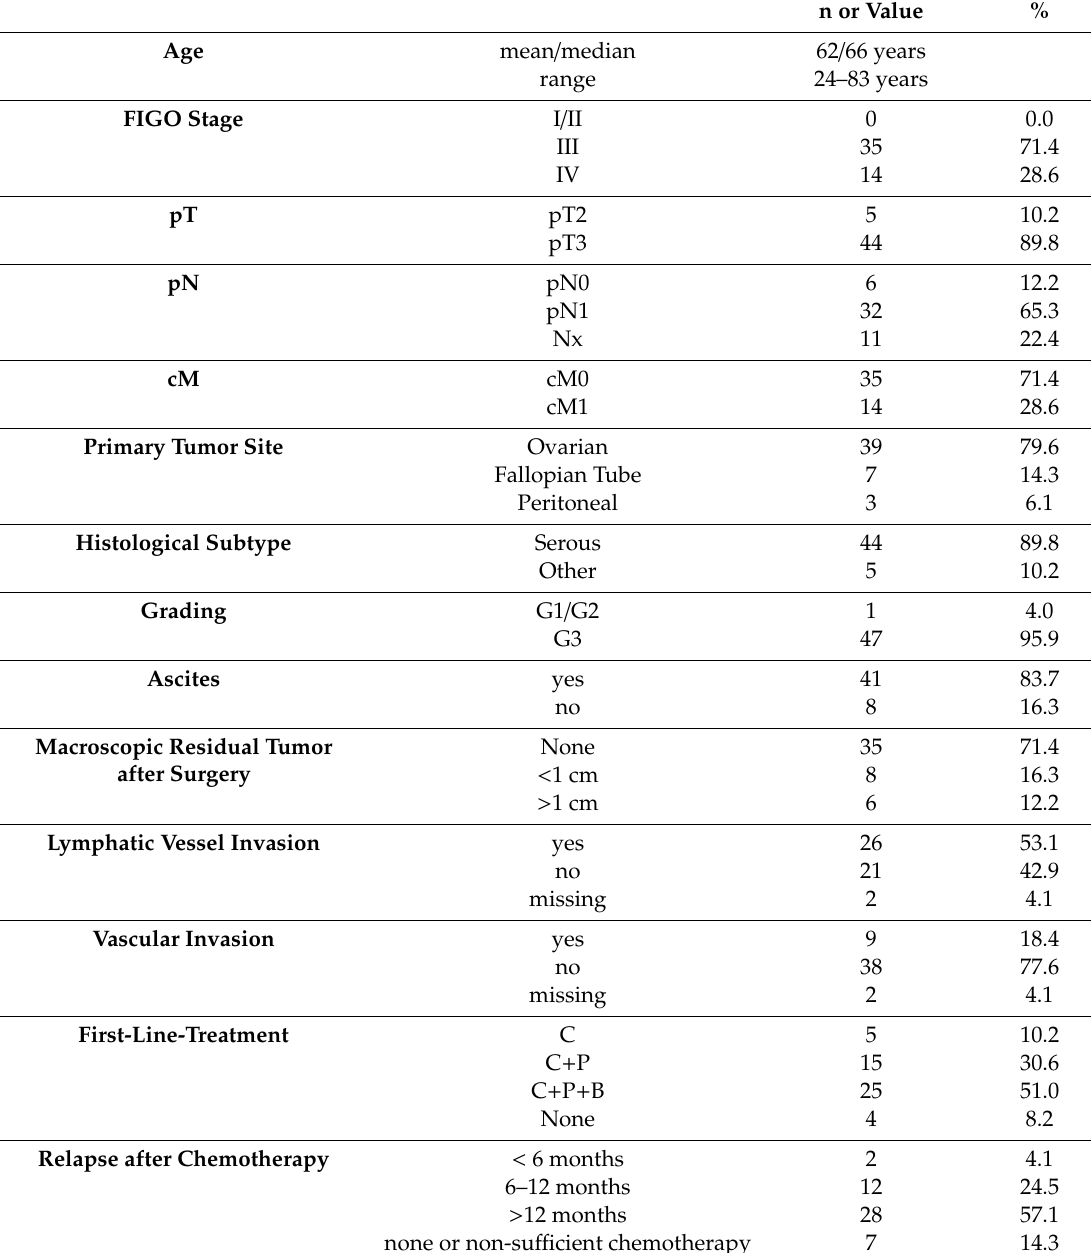
Table 1. Patient